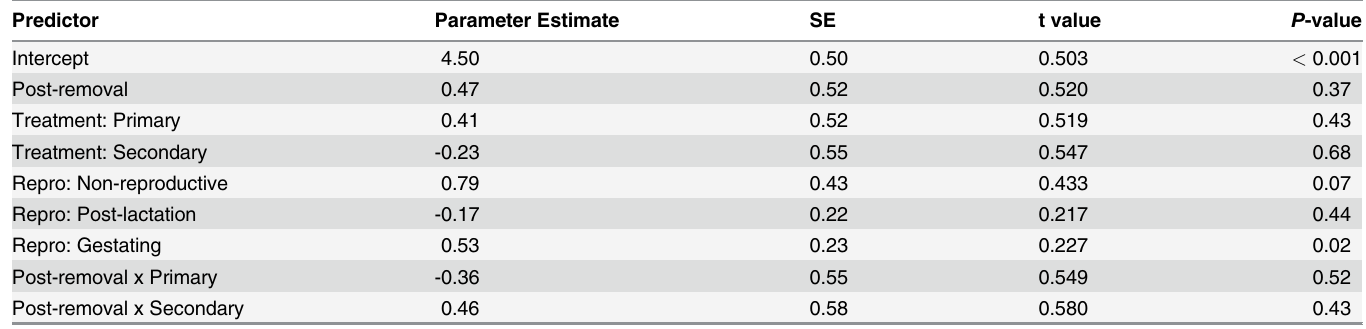
were between 1.3 and 58.5 ha (Table 1). Patterns of roosting area space use largely were consis- tent between pre- and post-treatment in our primary and secondary roost removal treatment groups, particularly evident in the distances between weighted colony roosting area centroids (Table 1, Fig. 1). However, space use by and roosting area centroids of our control colony dif- fered substantially between years (Table 1). Roost network degree centralization significantly was greater than random for primary re- moval and control colonies, but not the secondary roost removal colony pre-treatment (Table 1). Roost network clustering differed from random networks in both the primary and Table 4. Factors in fl uencing distances moved between roosts by female northern long-eared bats. Predictor